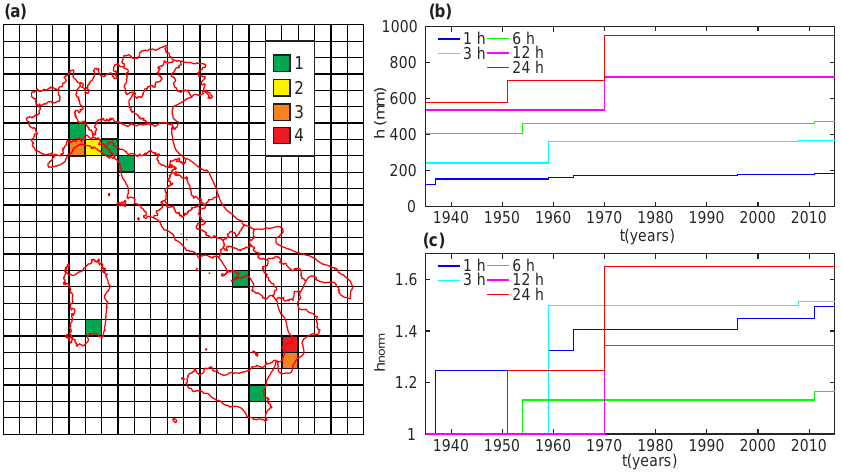
Figure 5. (a) Number of record-breaking events per cell over a 50km grid. Record-breaking rainfall depths for the five considered durations from 1935 to 2015 (b) in absolute values and (c) normalized against the 1935